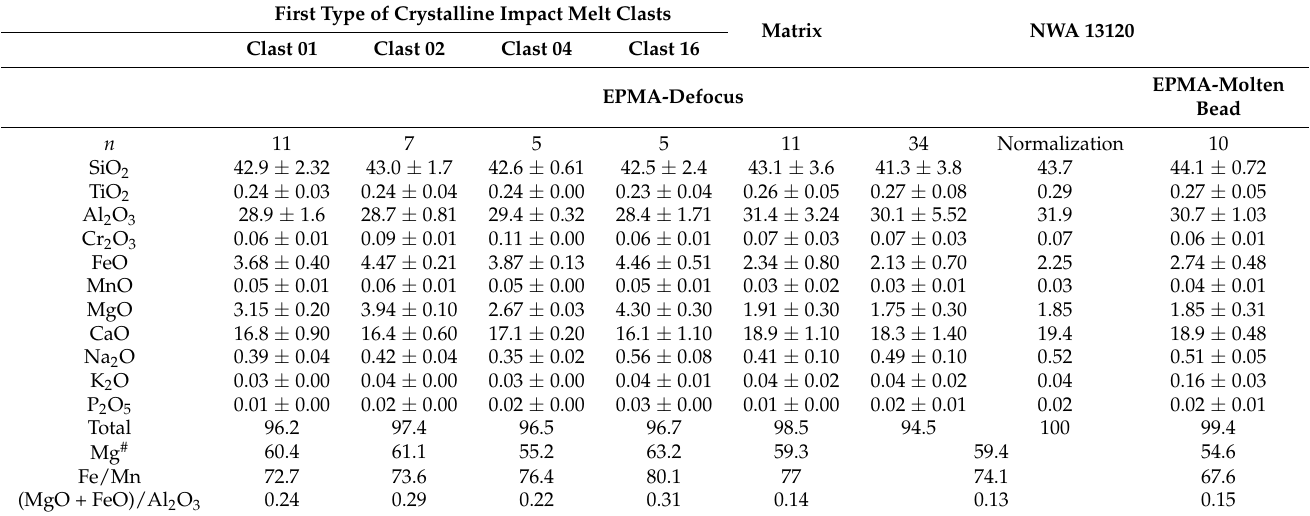
Table 4. Bulk compositions of some clasts, matrix, and NWA 13120